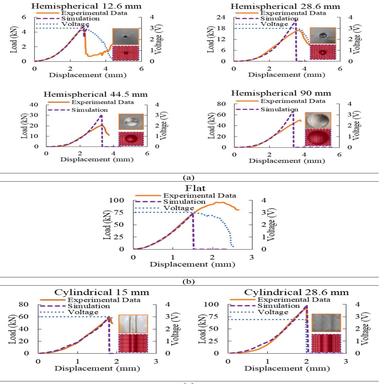
Comparison of through-thickness loading (local indentation) simulations versus experiments (a) Hemispherical punches (b) Flat punch (c) Cylindrical punches.